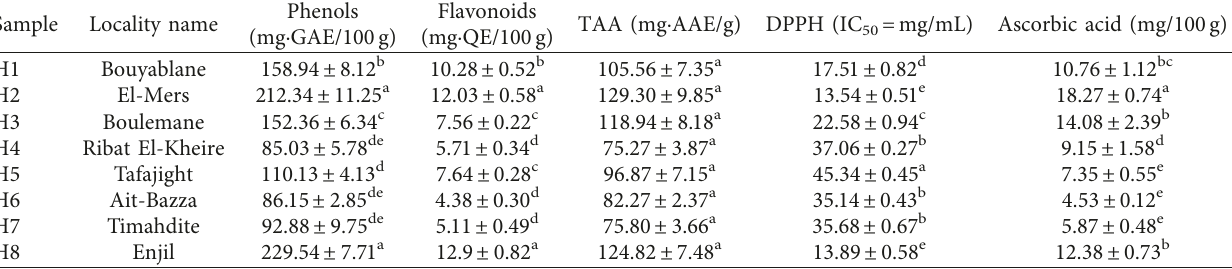
Table 5: Bioactive compounds and antioxidant activities.